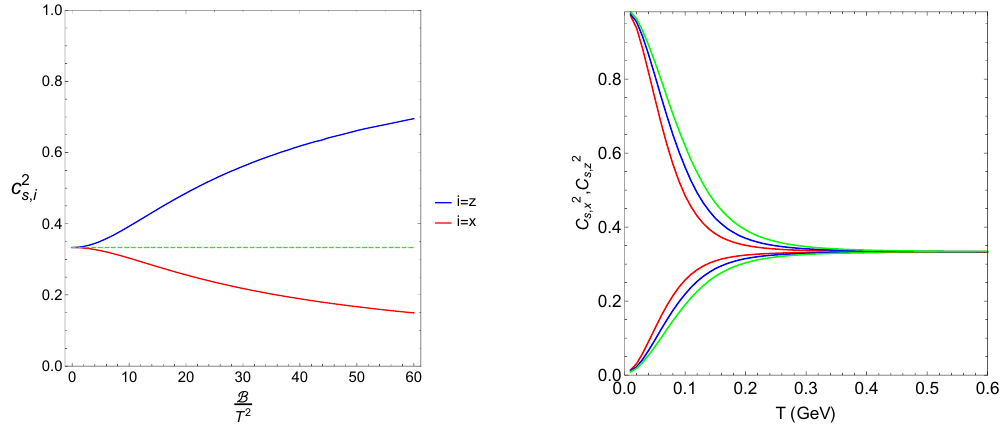
Figure 8 . Left panel: squared speeds of sound along the z and x directions (blue and red respectively) as a function of b = B /T 2 . The green dashed horizontal line represents the isotropic result c 2 = c 2 = 1 / 3 in the absence of magnetic field. Right panel: squared speeds of sound as s,x s,z a function of T for fixed values of B . The red, blue and green lines correspond to B = 0 . 2 GeV 2 , B = 0 . 3 GeV 2 and B = 0 . 4 GeV 2 respectively. The asymptotic values of c 2 limit are 1 and 0 respectively. This corresponds to the T → 0 limit on the right